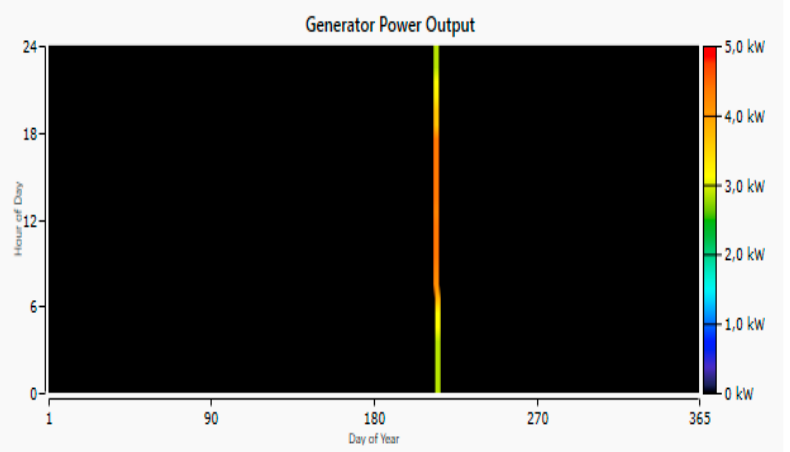
Figure 13. Generator output power.